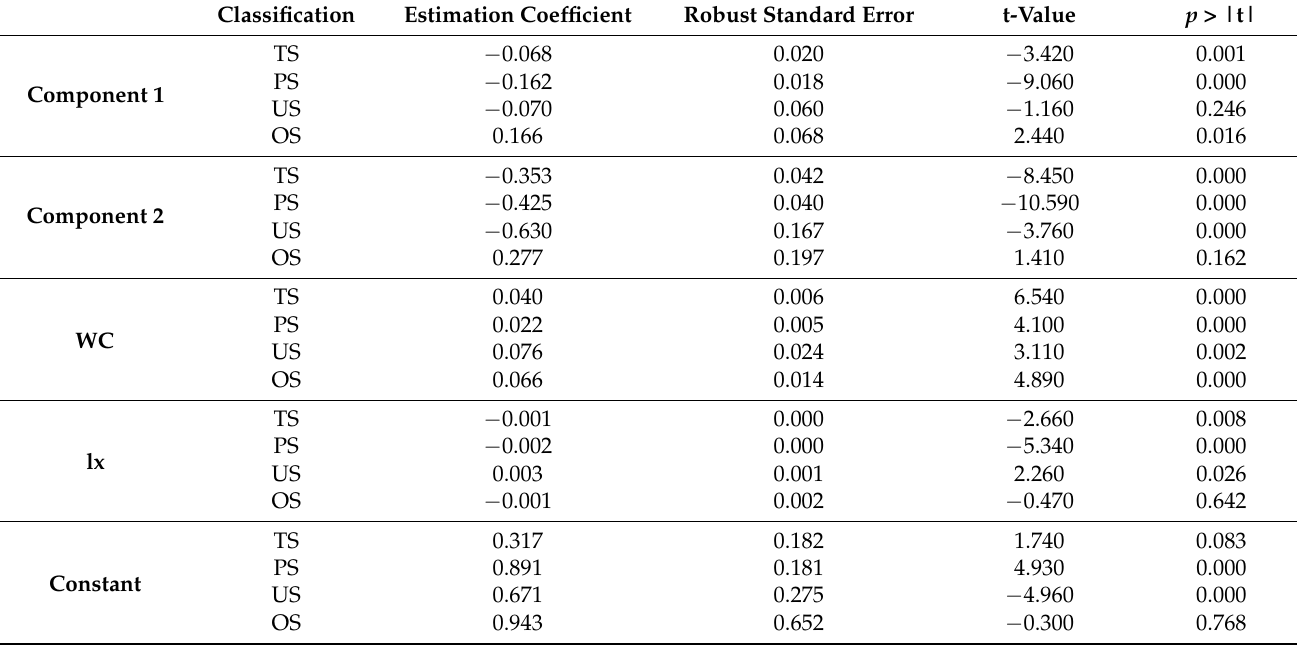
Table 7. Multiple regression analysis results obtained using ordinary least